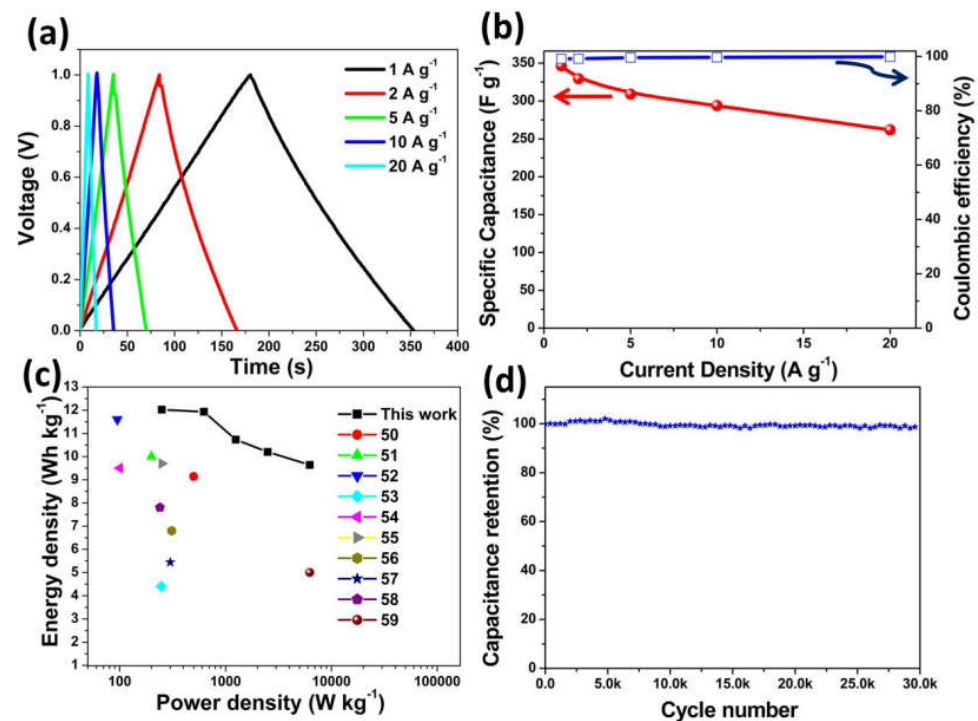
Figure 8. GCD curves ( a ) and specific capacitance, as well as Coulombic efficiency ( b ) of HPC700 at different current densities in HPC-700//HPC-700. ( c ) Ragone plot and ( d ) cycling stability of HPC700//HPC-700 at 5.0 A g −1 after 30,000 cycles.